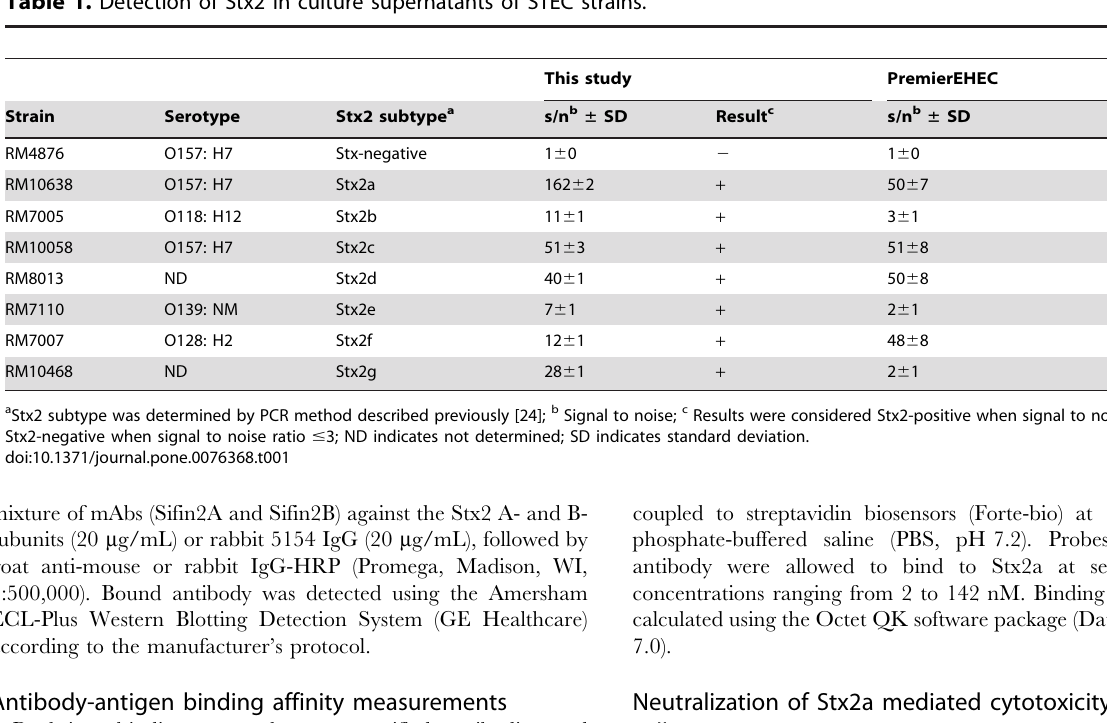
Table 1. Detection of Stx2 in culture supernatants of STEC strains.